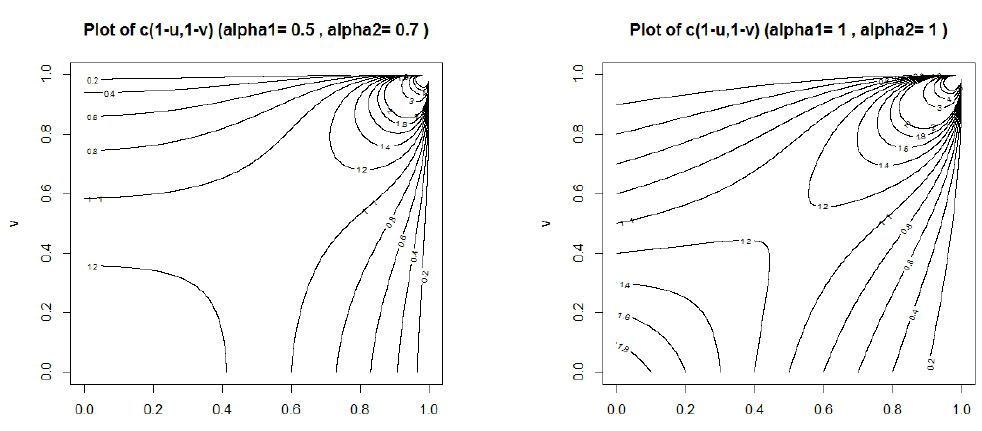
Figure 3.1: Plots of (cid:98) c ( u , v ) = c (1 − u , 1 − v ) for different α 1 and α 2 values.